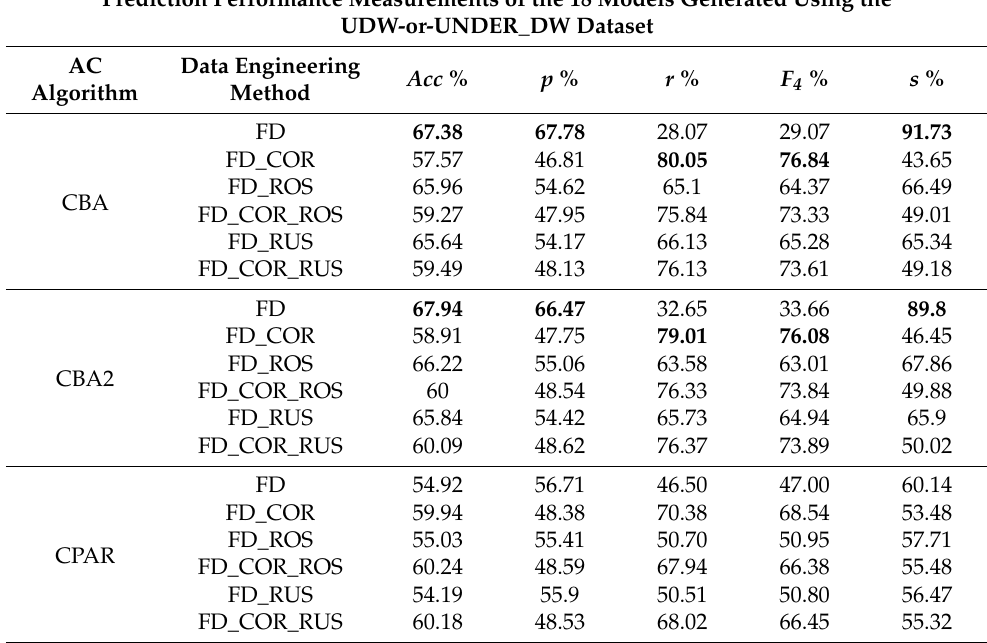
Table 11. Classification assessment of the 18 models built using the UDW-or-UNDER_DW dataset. Prediction Performance Measurements of the 18 Models Generated Using